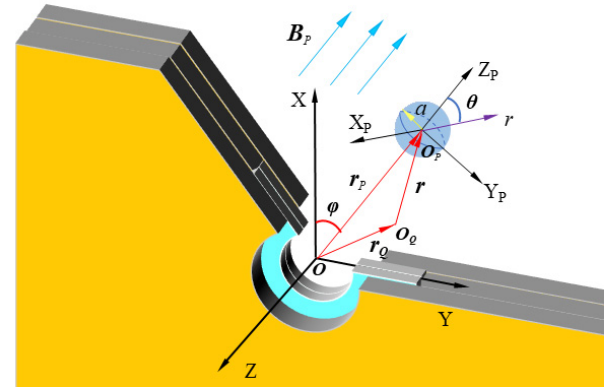
Figure 2. Magnetic field on the circular current-carrying conductor.